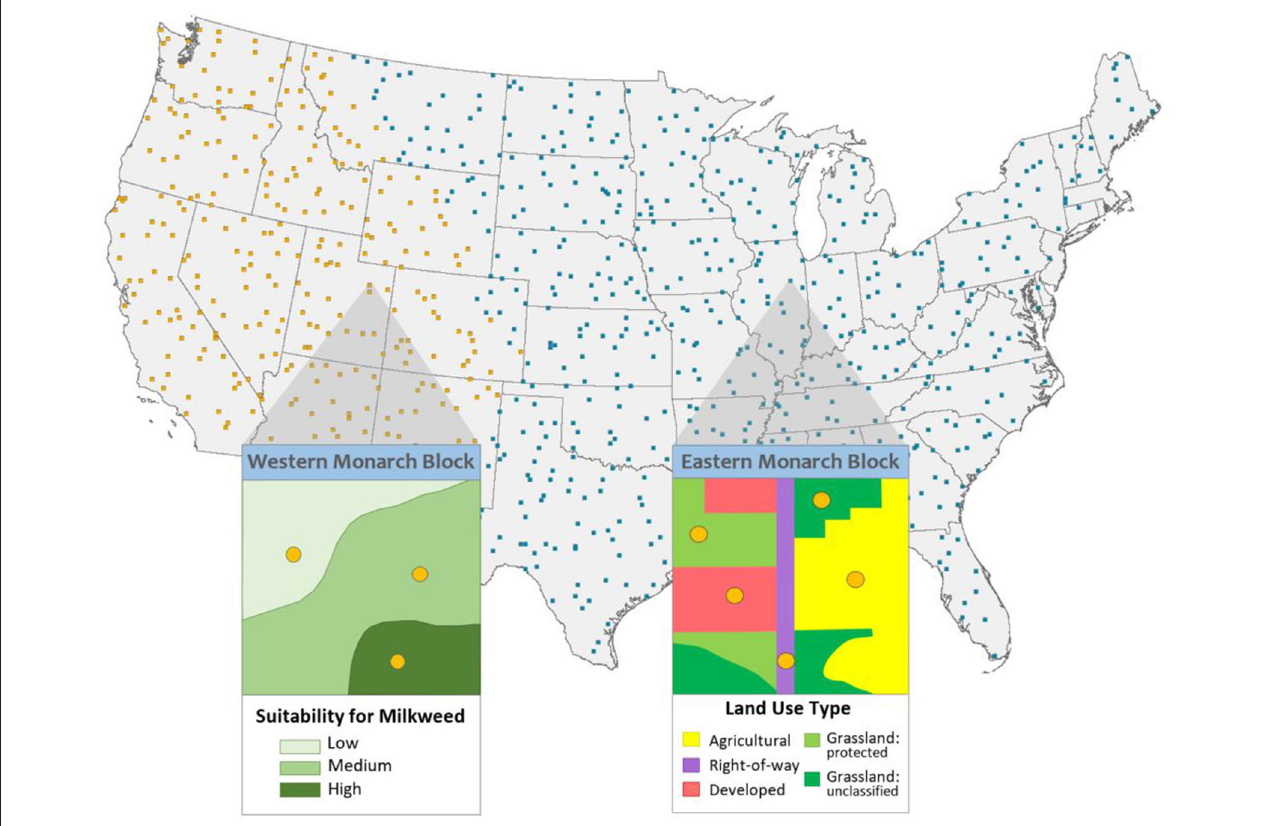
FIGURE 1 | Top 500 randomized [Generalized Random Tessellation Stratified (GRTS)] 10-km by 10-km sampling cells (‘monarch blocks’) for the western North American population of monarch butterflies (in yellow) and the eastern population (in blue). Inset 1: an example monarch block in the range of the western population, showing three strata, areas modeled as low-, medium-, and high-suitability for milkweed, per the western milkweed habitat suitability project (Dilts and Forister, 2017). Inset 2: an example monarch block from the eastern population depicting top random site locations for each of the five major land-use strata for sampling ( Thogmartin et al.,